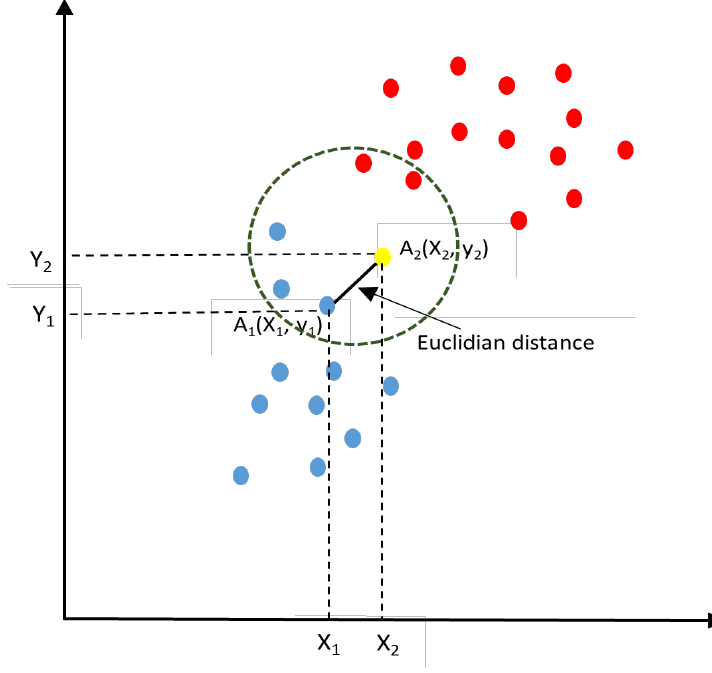
Figure 5. The K-nearest neighbor